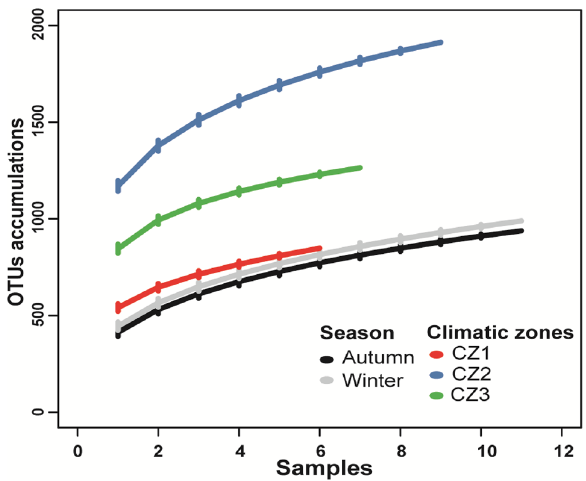
Figure 1. OTU accumulation curves for sequencing depth against OTU richness in different seasons (autumn and winter), and in three climatic zones, for the fungal composition recovered from industrial grain mill